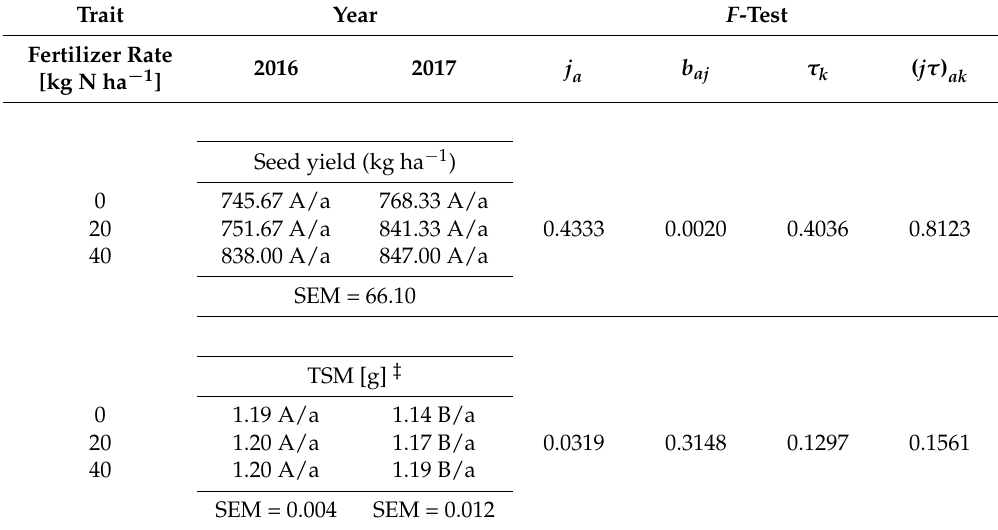
Table 5. Estimated seed yield (kg ha − 1 ) and thousand seed mass (TSM) (g) of chia (Genotype G8) based on model (2) cultivated at three different fertilizer rates (0, 20, 40 kg N ha − 1 ) at Ihinger Hof in 2016 and 2017, along with standard error of the mean (SEM) and F -tests ( n = 3, α = 0.05).